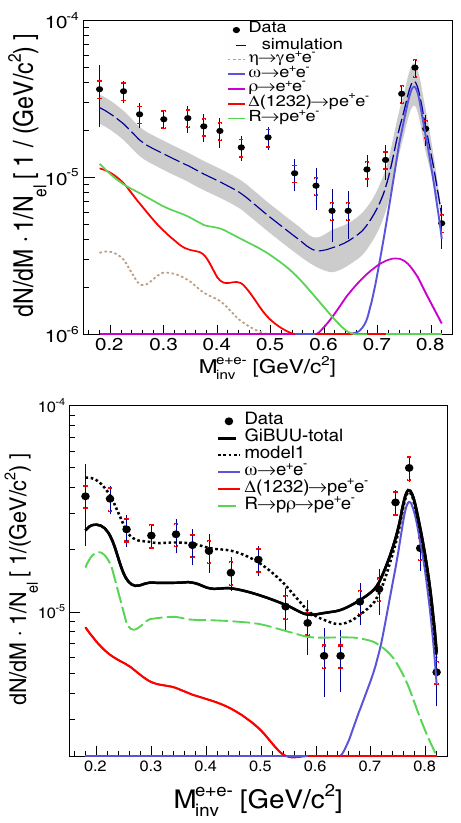
Figure 9. Top: Invariant mass distribution of dielectron pairs measured in the exclusive channel p + p → ppe + e − at E kin = 3 . 5 GeV compared to cocktail of baryonic and mesonic sources. The contribution from baryon resonances is separated into contribu- tions from Δ (1232) (red line) and higher mass states (green) as- suming constant etFF. Bottom: same data compared to calcula- tions using for the baryon resonance two step decay involving coupling to intermediate ρ meson state (for details see text).